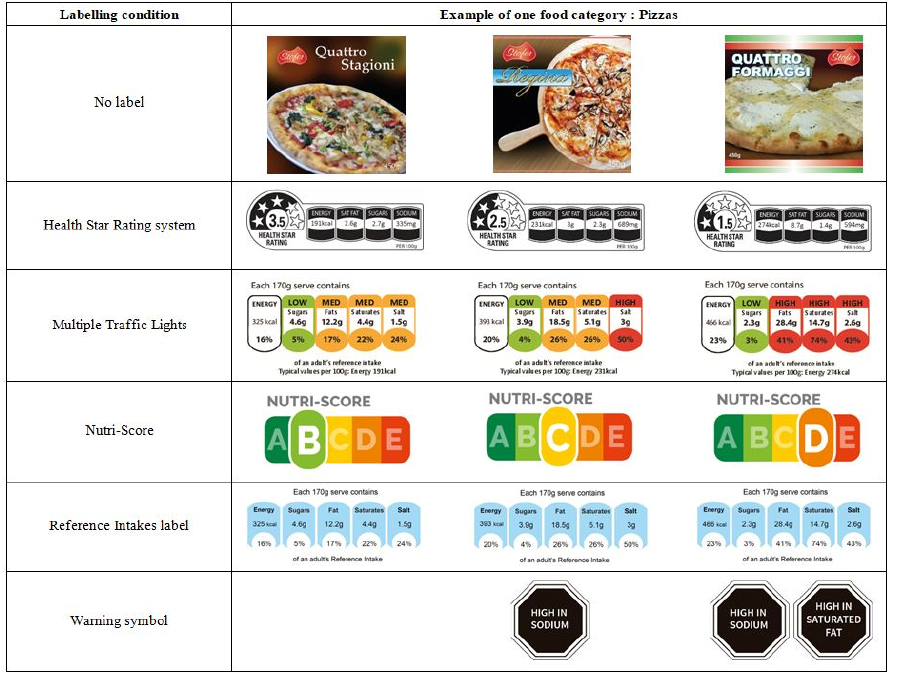
Figure 1. Example of the set of three pizzas with the corresponding labelling conditions.